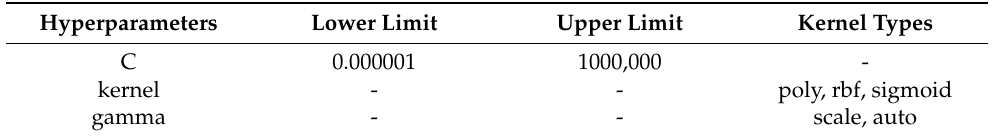
Table 3. Search space of the SVM method.